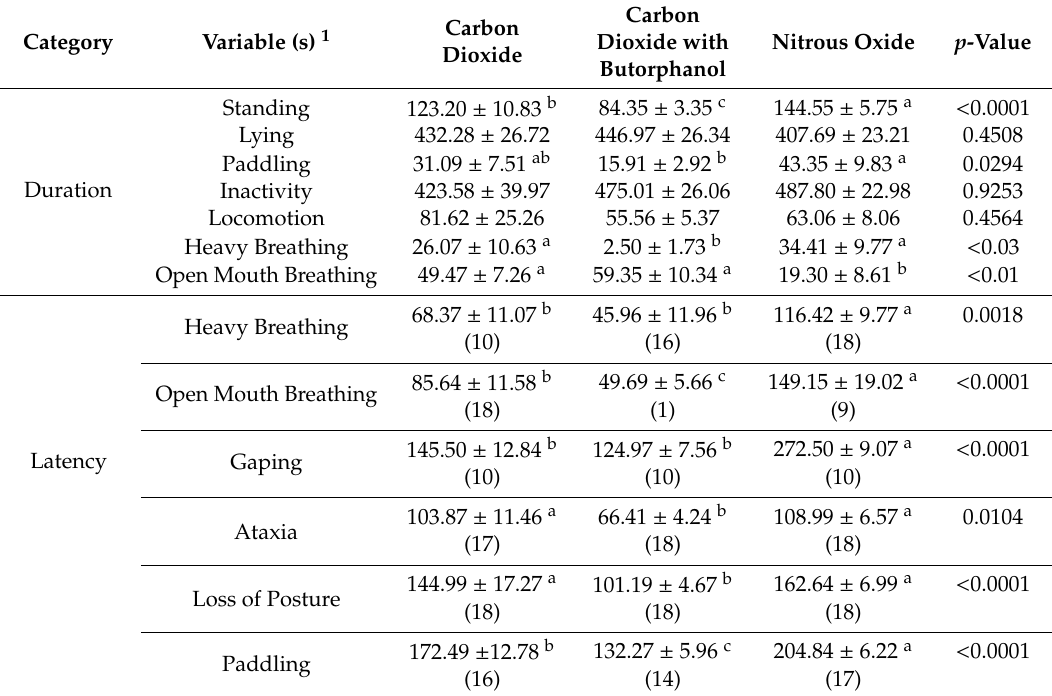
Table 3. Behavioral state results (mean ± SE) for multiple pairs of pigs subjected to the three treatments. Duration refers to the total elapsed time from onset to the cessation of the indicated variable. For the latency category, the numbers in parentheses indicate how many animals out of 18 in each treatment performed that specific behavior listed under column 2, “Variable”.